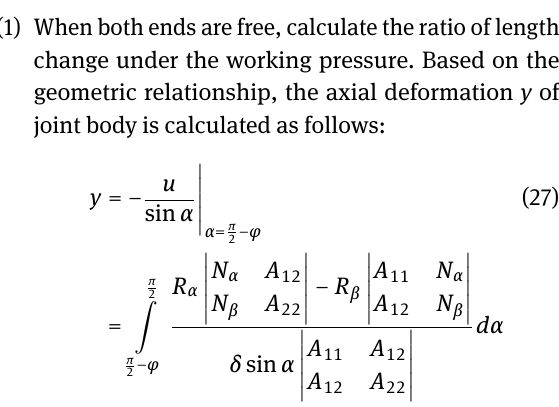
Figure 9: Lateral stiffness at different H, and the initial structure vector H 0 = [0.1, 0.1, 0.1, 40] : (a) varied initial winding angles θ 0 ; (b) varied meridional radii R α ; (c) varied axial lengths L ; (d) varied circumferential radii at the ends r